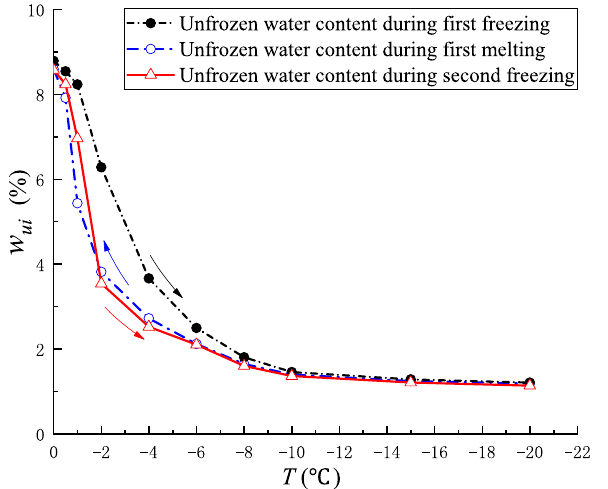
Figure 6. Relationship between unfrozen water content and temperature of coal sample C during